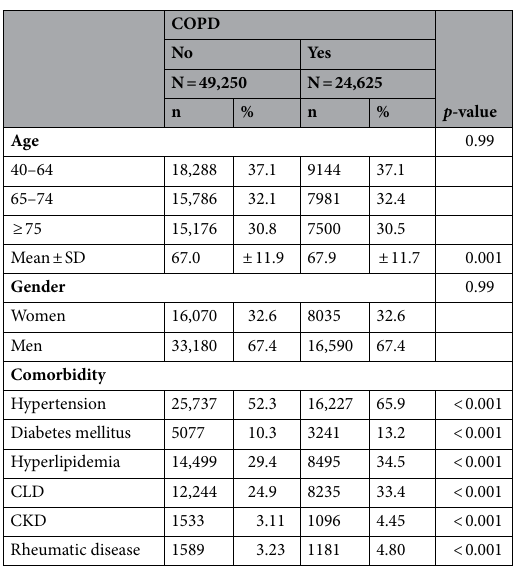
Table 1. Baseline characteristics for individuals with and without COPD. CKD, chronic kidney disease; CLD, chronic liver disease and cirrhosis; COPD, chronic obstructive pulmonary disease; SD, standard